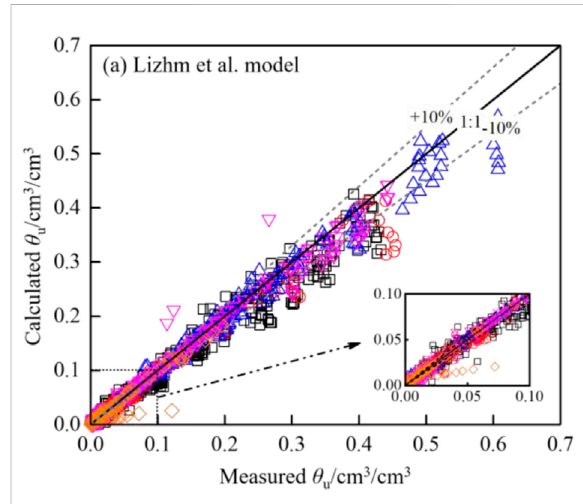
FIGURE 1 Fitting performance of 1 theoretical model. In the fi gure, black square stands for clay, blue up triangle stands for silty clay, red circle stands for silt, magenta down triangle stands for sand, and orange rhombus stands for